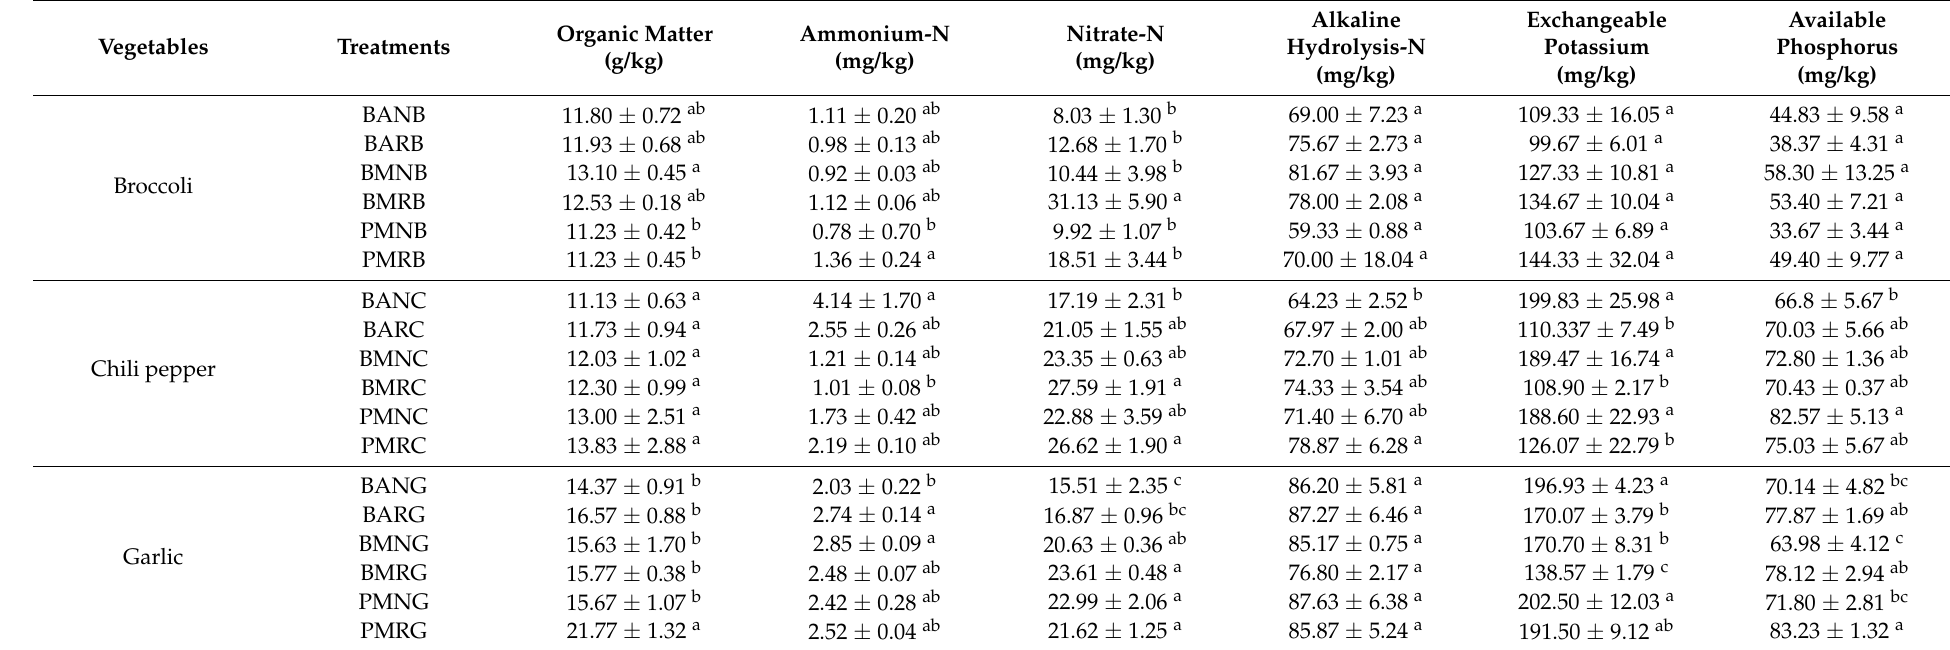
Table 2. Soil properties in three different vegetable fields under different